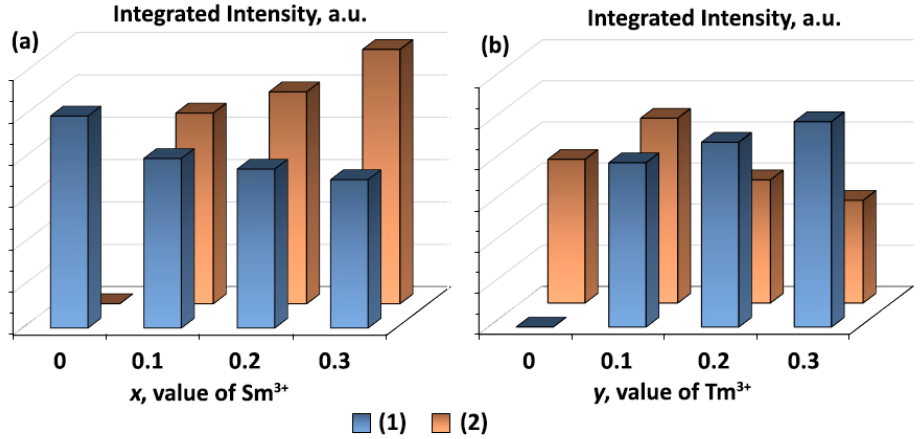
Figure 8. Integrated intensity of Tm 3+ (1) and Sm 3+ (2) emissions for Ca 9 Gd 0.9 − x Tm 0.1 Sm x (PO 4 ) 7 ( a ) and Ca 9 Gd 0.9 − y Tm y Sm 0.1 (PO 4 ) 7 ( b ) at λ ex = 356 nm.